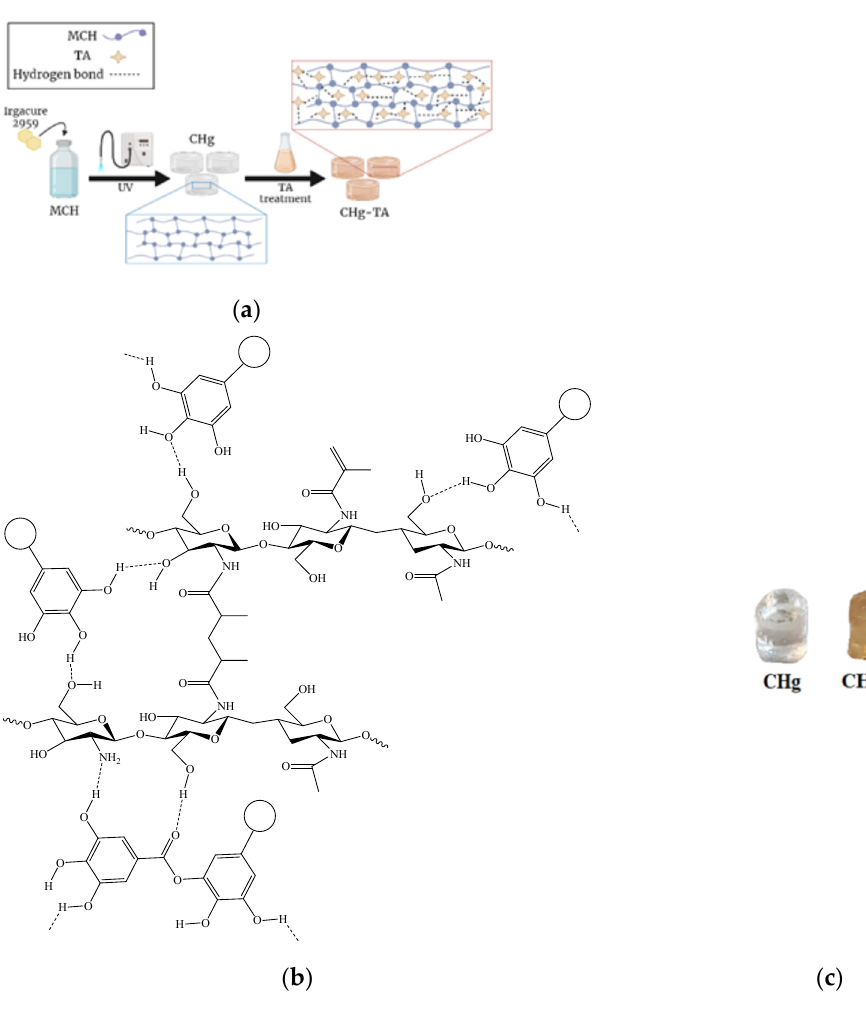
Figure 3. ( a ) Representative scheme of the CHg and CHg-TA preparation; ( b ) formation of hydrogen bonds between MCH functional groups and TA; ( c ) digital photo of CHg and CHg-TA, showing that the TA adsorption can be visually confirmed by the formation of the typical light brown color of TA [72]. After the CHg swelling in the TA solution, the color change of the hydrogels from light yellowish to brownish (Figure 3c) suggests the formation of interactions between TA and CHg. The F&C results prove the successful adsorption of TA by CHg, and the total phenolic content in CHg-TA was measured at 0.094 ± 0.07 mg/mL. Therefore, no redox activity of CHg was detected, as expected by the chitosan